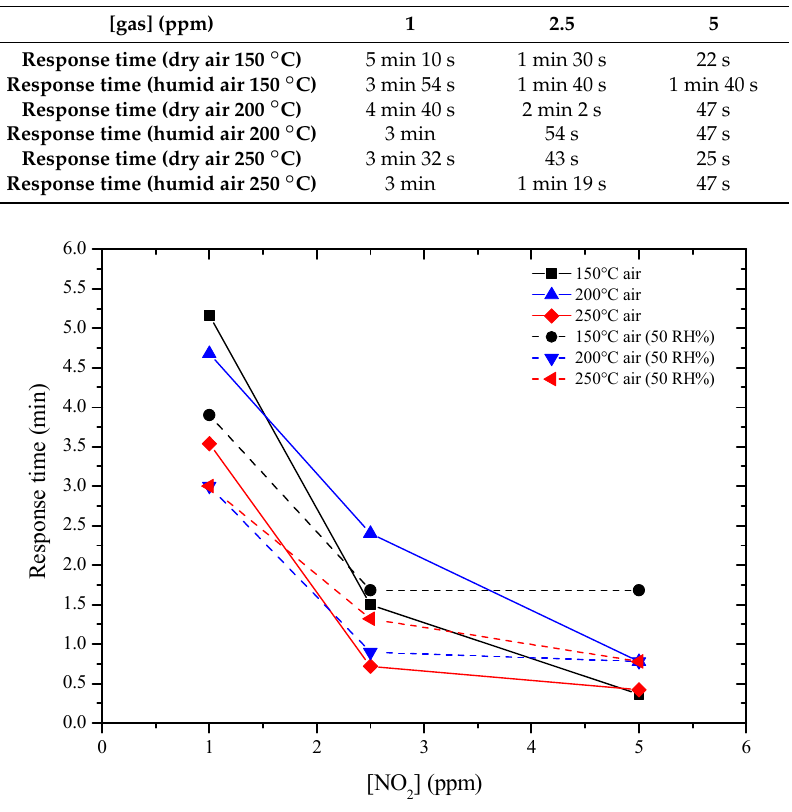
Figure 12. Response time of GC sol-gel sensor in function of NO 2 concentration and temperature.